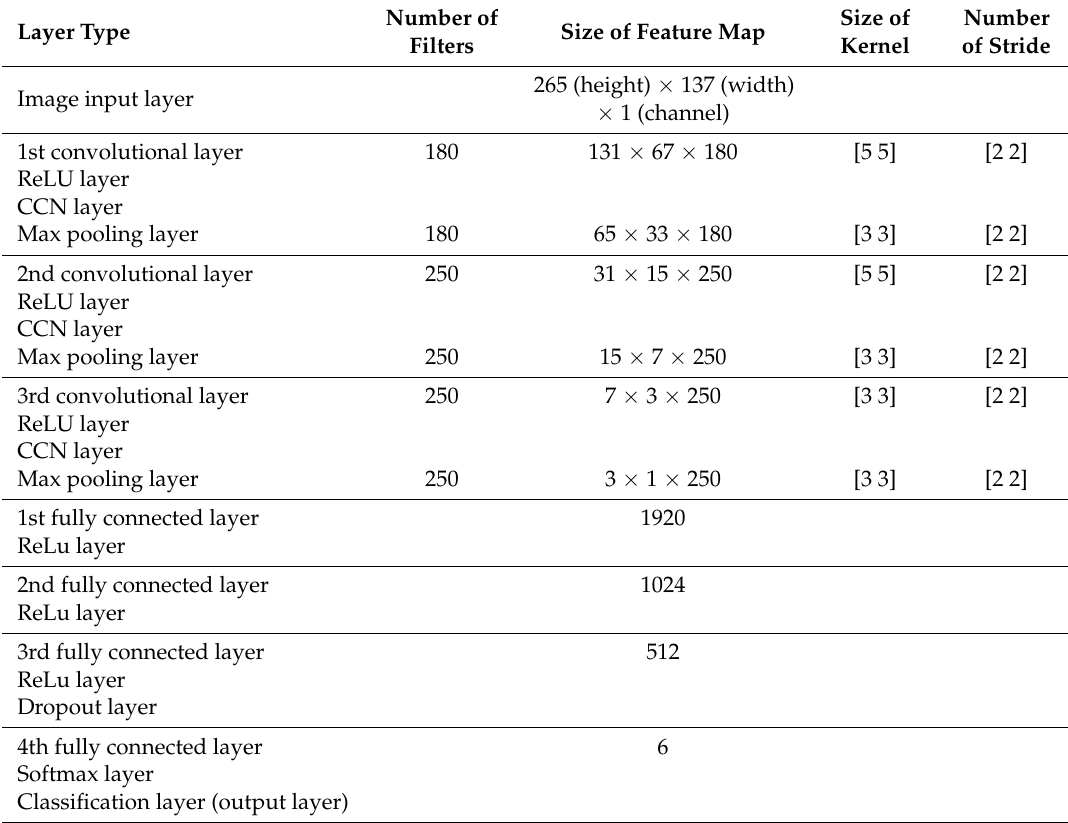
Table 2. The CNN architecture used in our